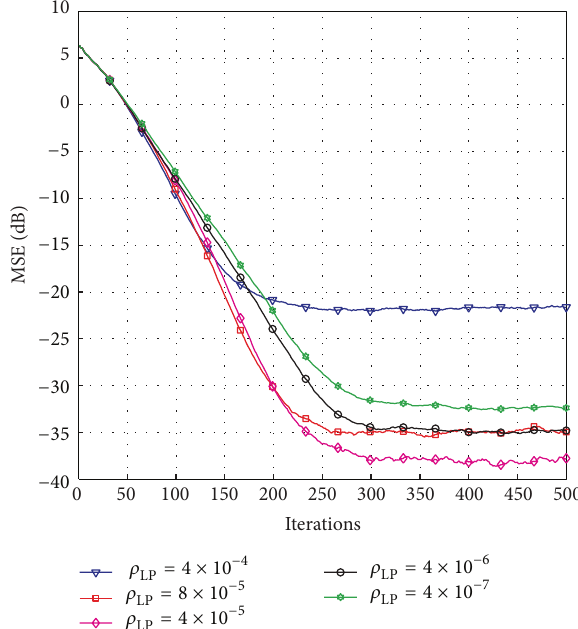
Figure 4: Effects of 𝜌